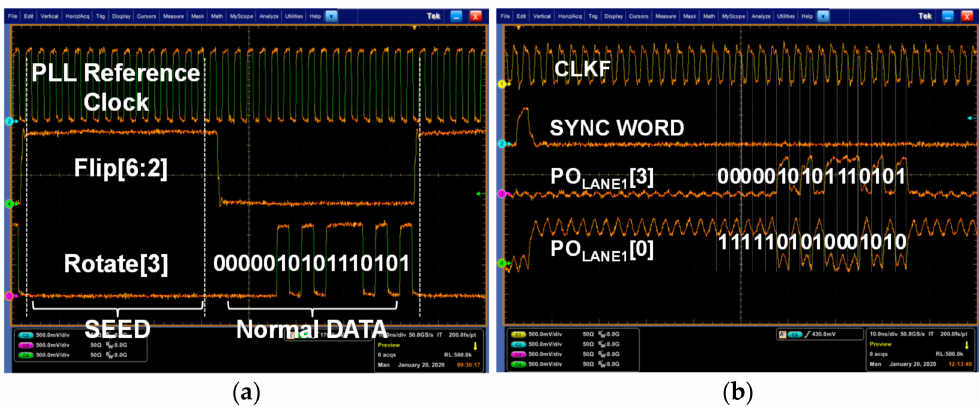
Figure 15. Measurement results for function evaluation of MIPI C-PHY receiver chip: ( a ) Data supplied from MIPI C-PHY transmitter chip; ( b ) Output data of MIPI C-PHY receiver chip.